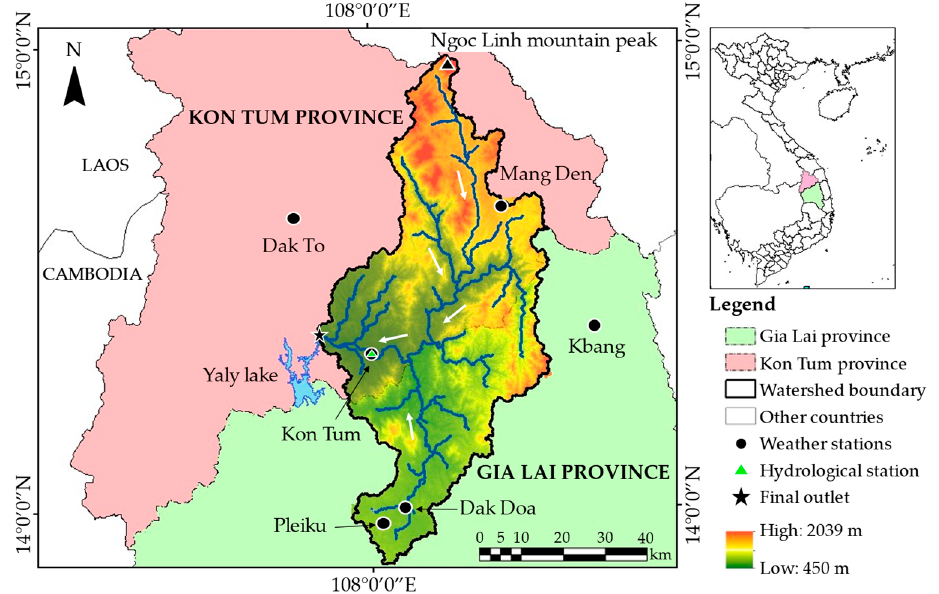
Figure 1. Location of the Dakbla watershed. The model performance was evaluated at Kon Tum hydrological station.